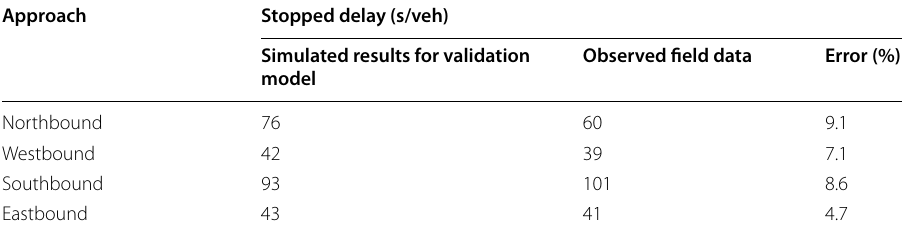
Table 3 Comparison of stopped delay for validation model with field data Approach